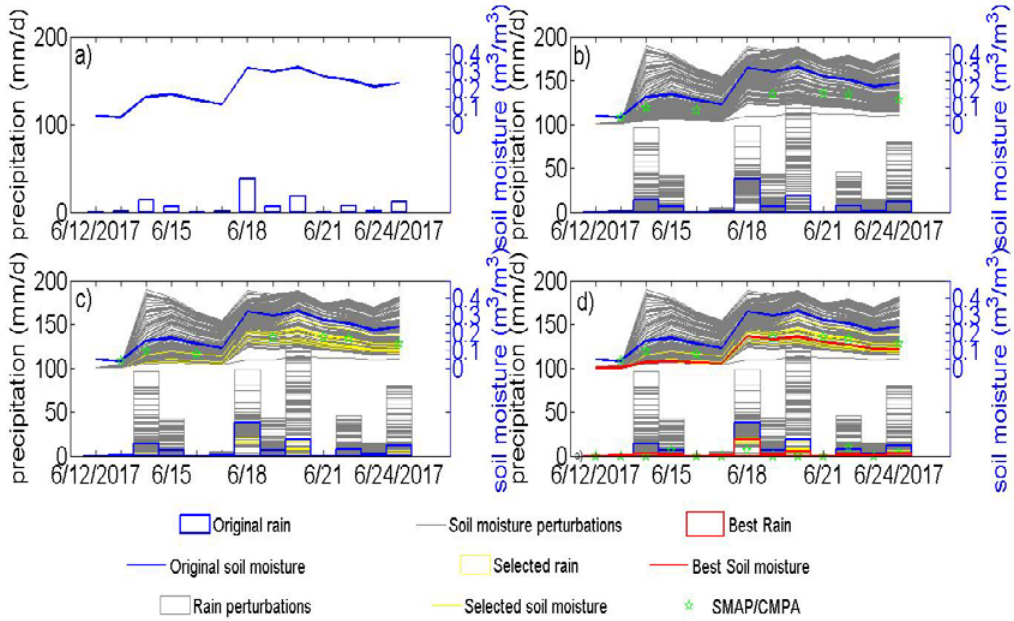
Figure 2. Graphical representation of assimilation algorithm using SM data. The figures show an example for a grid point at 109.3°E, 22.1°N from June 12 to 24, 2017. ( a ) Original rainfall (blue bars) from GPM to be corrected and its associated SM data (blue lines) simulated by API model. ( b ) Including 100 simulations of artificially perturbed rainfall data (grey bars) and their associated SM data (grey lines). ( c ) As in ( b ) but including the best 10 simulations in yellow. ( d ) As in ( c ) but with the final output rainfall and SM data in red. The reference data of rainfall (from CMPA) and SM (from SMAP) are marked with green pentacles.